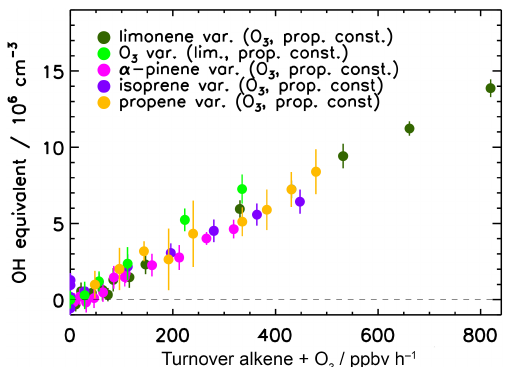
Figure 5. Signals as OH equivalents during flow tube experiments using the cell with the long inlet for very high alkene and ozone concentrations in the presence of high concentrations of propane as OH scavenger. Experimental conditions are shown in Table 1. An unexplained OH signal is observed, which correlates with the turnover rate of the alkene ozonolysis reaction (room temperature and ambient pressure). Turnover rates are not high enough to ex- plain observed OH production inside the fluorescence cell due to the dilution of reactants at the reduced pressure of